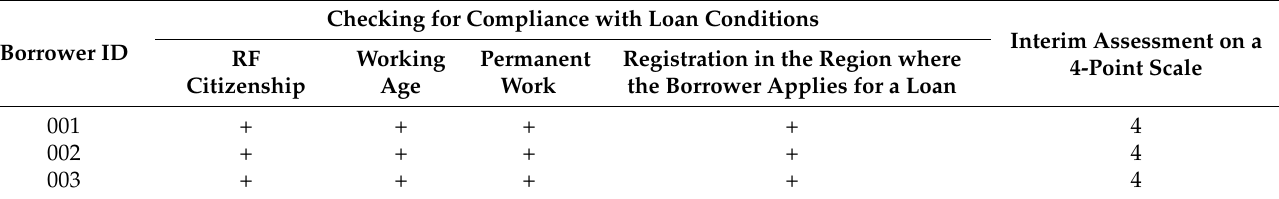
Table 10. Step 1: checking borrowers for compliance with loan conditions. Checking for Compliance with Loan Borrower ID